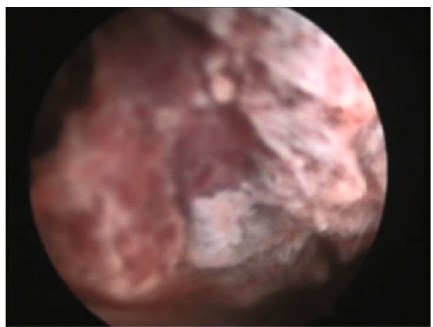
Figure 5: Hysteroscopic image showing an ectopic pregnancy at the level of the cesarean section scar.